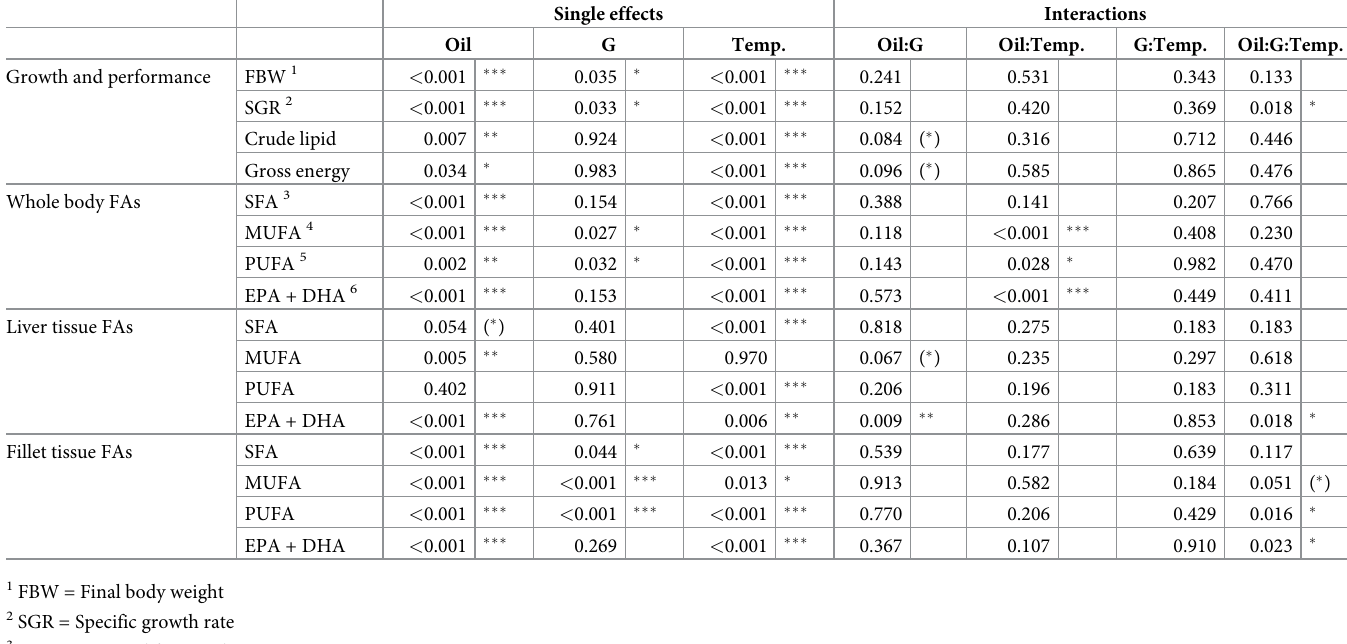
Table 4. Statistical significance of effects (p-values) caused by dietary fish oil level (Oil), genistein supplementation (G), rearing temperature (Temp.), and the inter- action of either two factors or all three factors. P-values are given for effects on selected growth and performance parameters, body nutrients, and fatty acids (FAs) of dif- ferent tissues of gilthead sea bream at the end of the 8 week